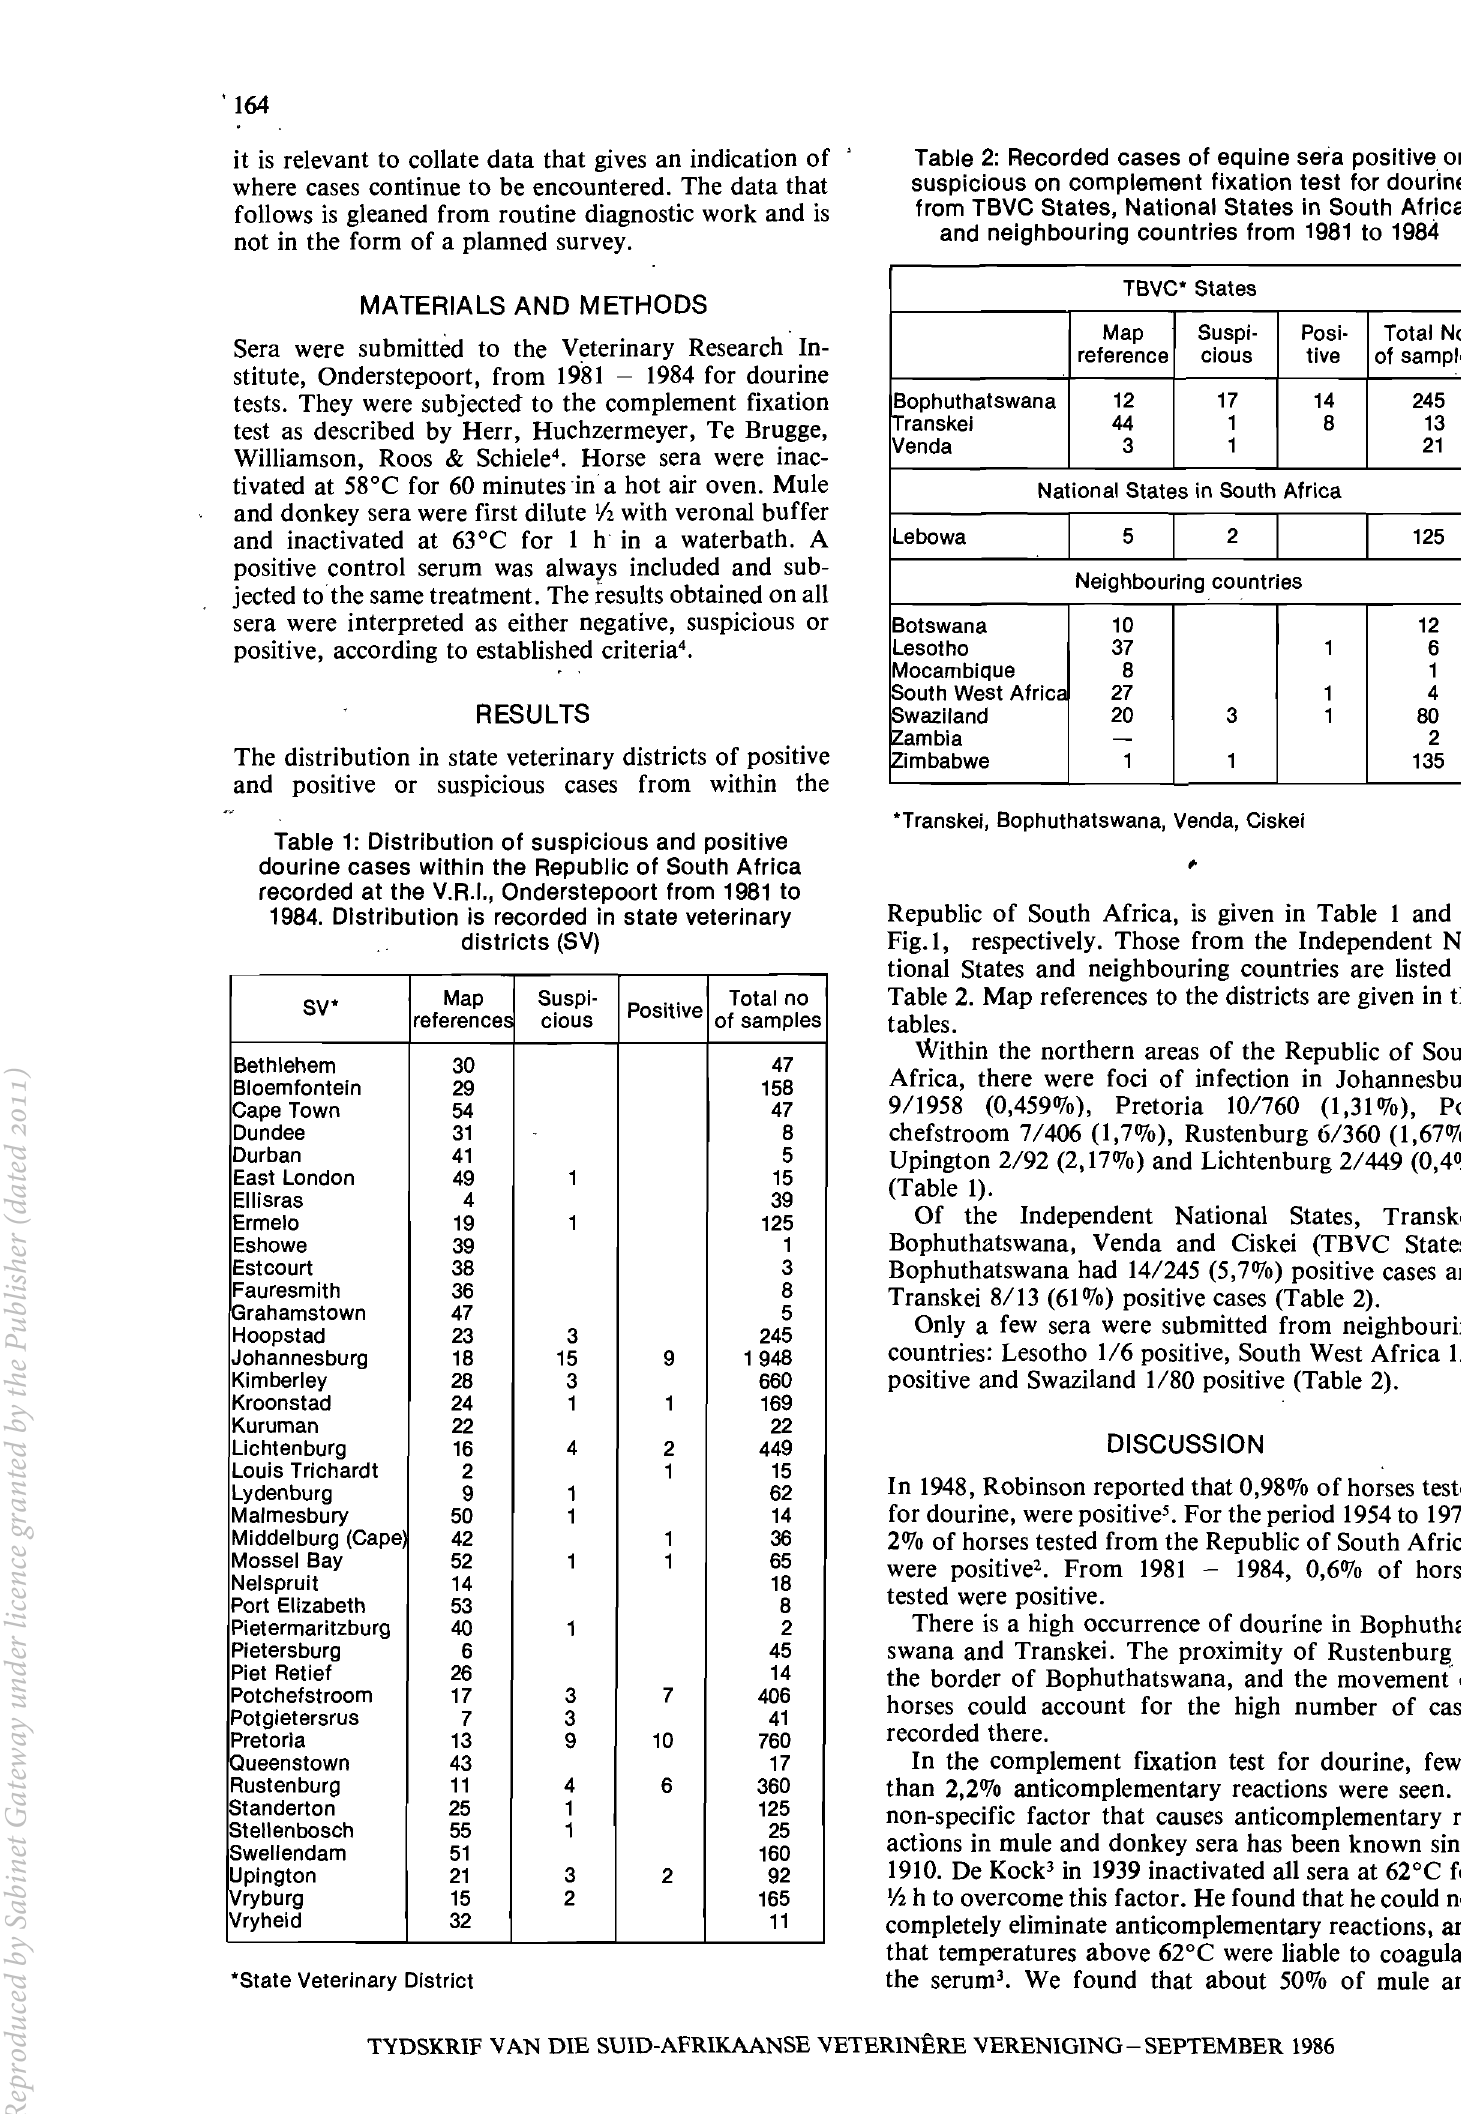
Table 1: Distribution of suspicious and positive dourine cases within the Republic of South Africa recorded at the V.R.I., Onderstepoort from 1981 to 1984. Distribution is recorded in state veterinary Fig. 1 , respectively. Those from the Independent Na districts (SV) tional States and neighbouring countries are listed in Table 2. Map references to the districts are given in the